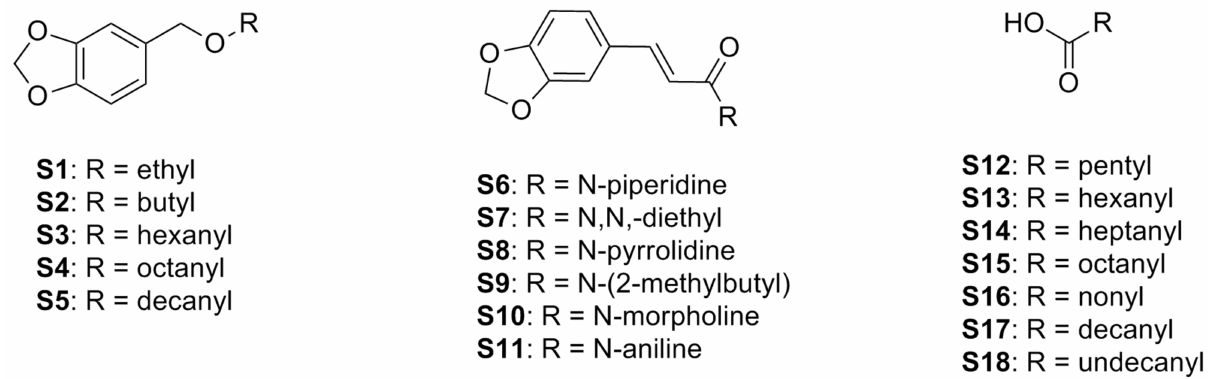
Figure 3. Chemical structure of synthetic compounds with potential antifungal effect against Leucoa- garicus gongylophorus